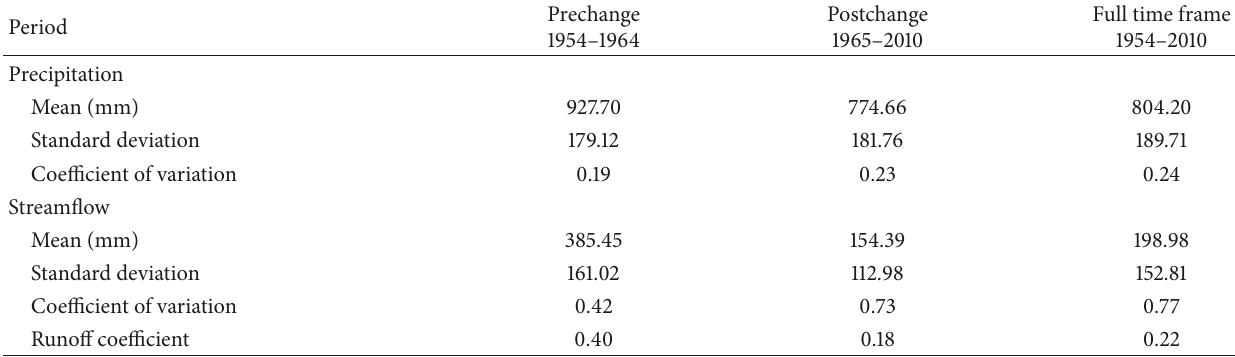
Table 2: Summary of annual precipitation, streamflow, and runoff coefficient during 1954–2010.